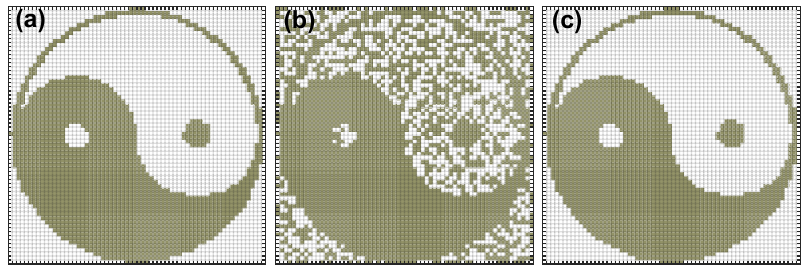
Figure 3: Reconstruction of a binary image by a coherent laser network with a properly trained weight matrix. (a) A binary 64 × 64 pixel image memorized by the CLN. (b) A corrupted version of the memorized binary image is used as initial phase distribution of the trained CLN. (c) The original image is reconstructed as the network evolves to its equilibrium